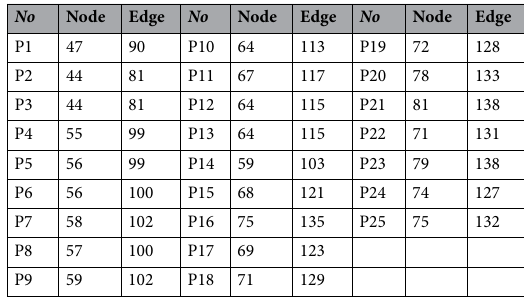
Table 2. Statistics of nodes and edges of the 25 generations of